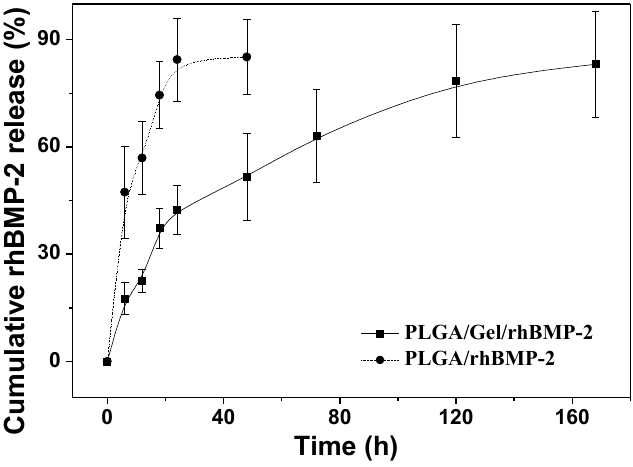
Figure 7. Release kinetics of rhBMP-2 from PLGA/rhBMP-2 and PLGA/Gel/rhBMP-2